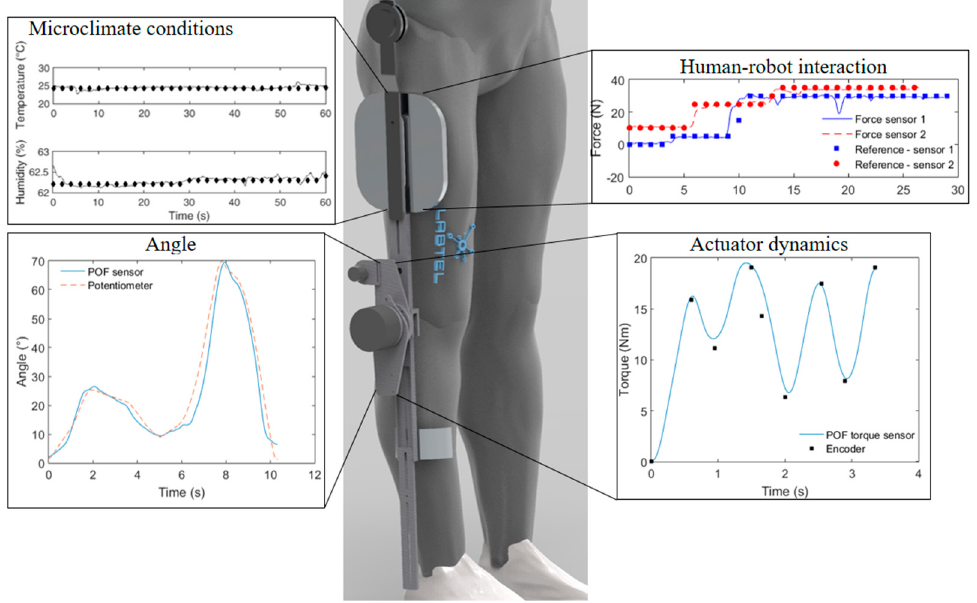
Figure 6. POF-based sensors on wearable robots’ applications.